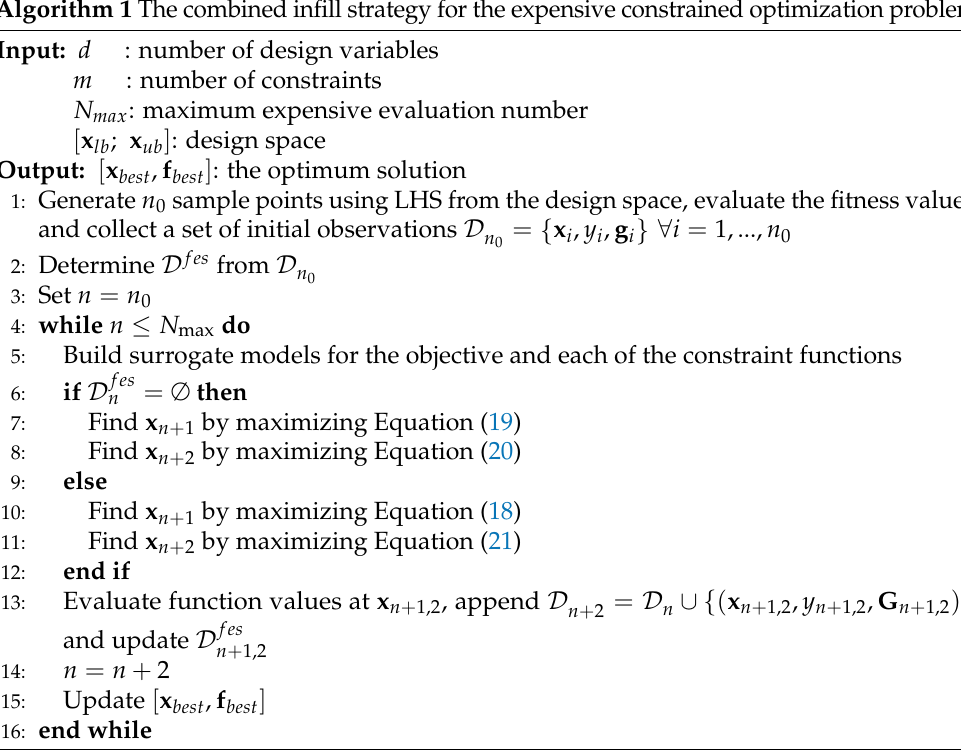
Algorithm 1 The combined infill strategy for the expensive constrained optimization